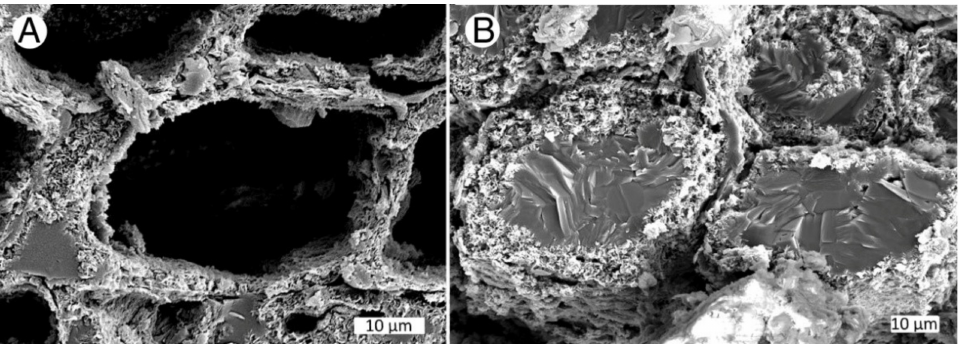
Figure 33. Miocene wood from Rainbow Ridge opal mine, Virgin Valley, northern Nevada, USA. ( A ) Organic templating causes deposition of amorphous opal in cell walls. ( B ) Lumen were later filled with solid opal, intercellular spaces remained open.